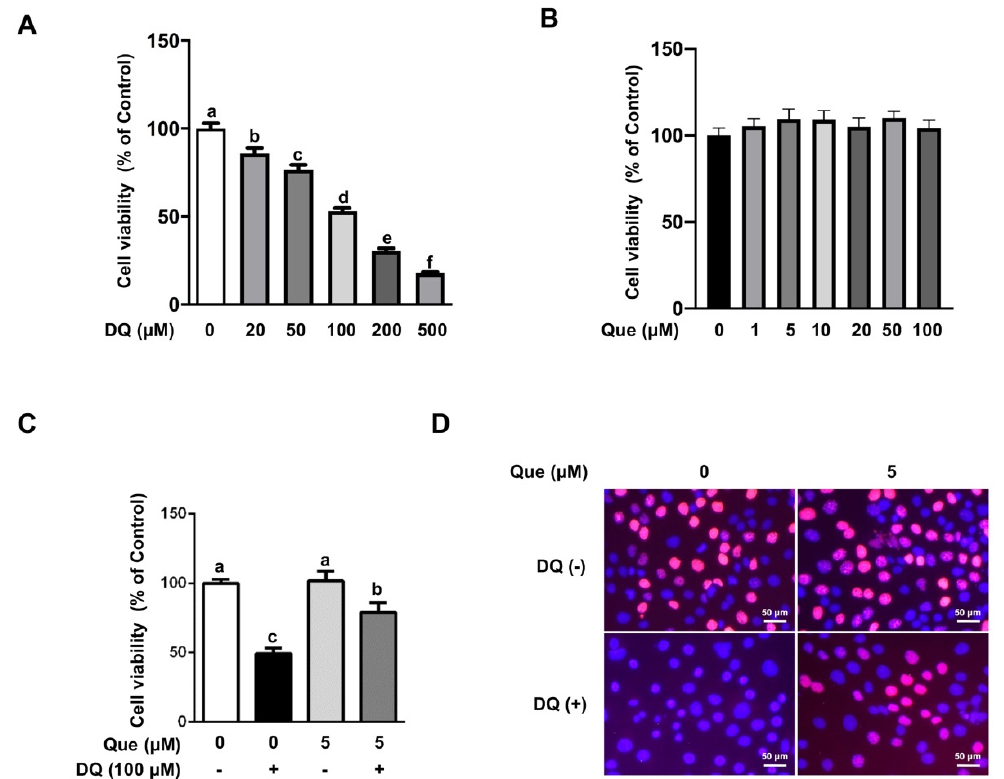
Figure 1. Effects of quercetin and/or diquat on cell viability in IPEC-1 cells. Cell viability of IPEC-1 pretreated with different dosages of ( A ) diquat for 6 h or ( B ) quercetin for 24 h were determined. IPEC-1 cells were pretreated with 5 µ M quercetin for 24 h and then challenged with 100 µ M diquat for 6 h. ( C ) Cell viability was measured by a CCK assay. ( D ) Cell proliferation was determined by EdU staining, magnification × 400. Representative experimental results were repeated in three independent experiments and values are means ± SEMs, n = 3. Means without a common letter are considered as a significant difference, p < 0.05.